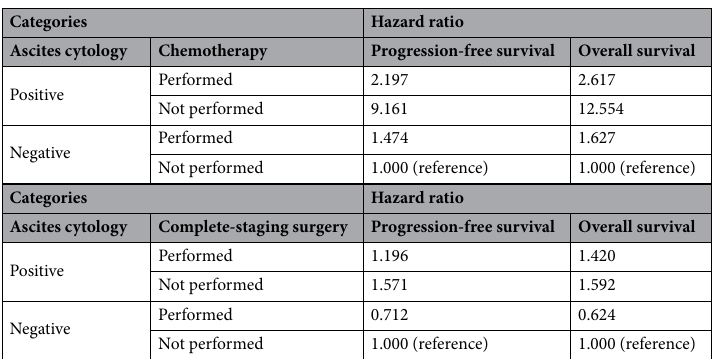
Table 3. Effect of chemotherapy and complete-staging surgery performance on positive ascites